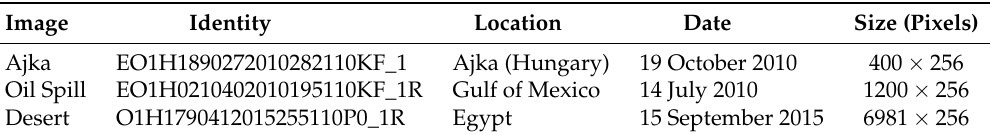
Table 1. Summary of information on the Hyperion datasets used for the analysis: Identity, location, date and size of the images.